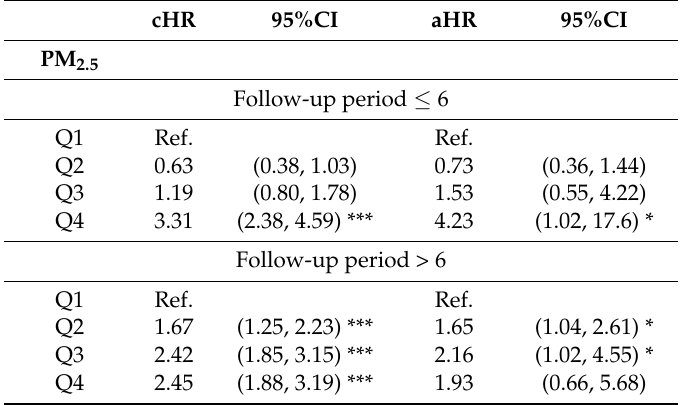
Table 4. Differences in nephrotic syndrome incidences and associated HRs in participants exposed to daily average concentrations of PM 2.5 stratify by follow-up